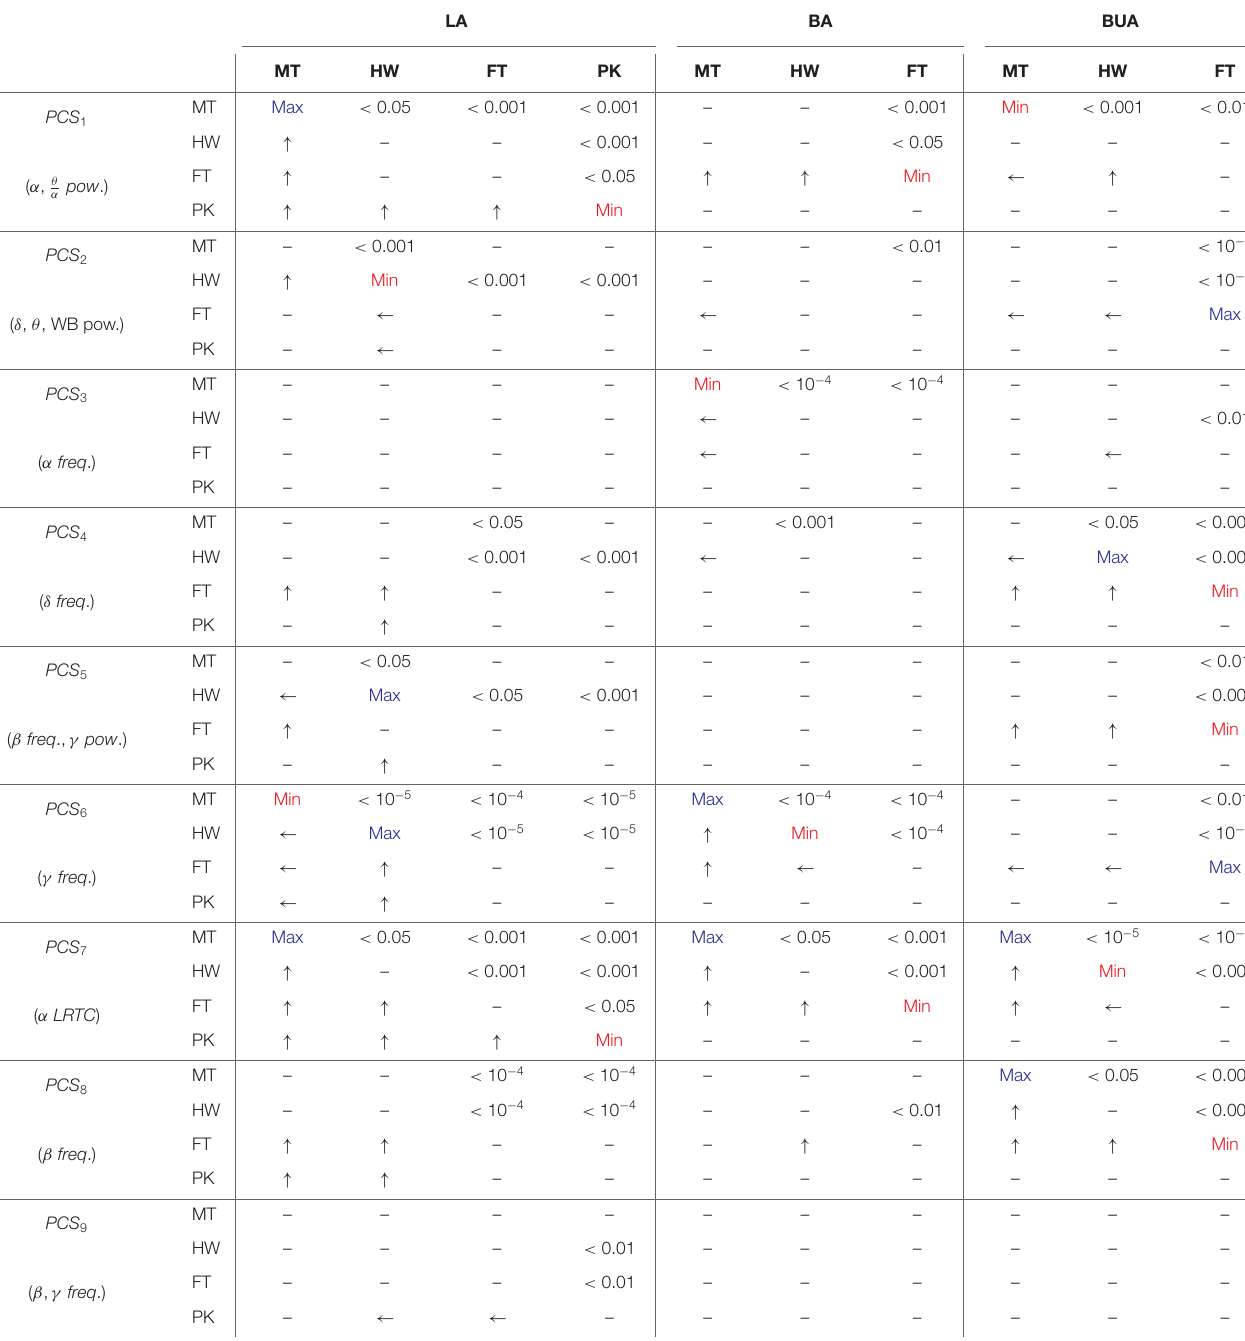
TABLE 2 | Tukey post-hoc multiple comparison testing for within-task